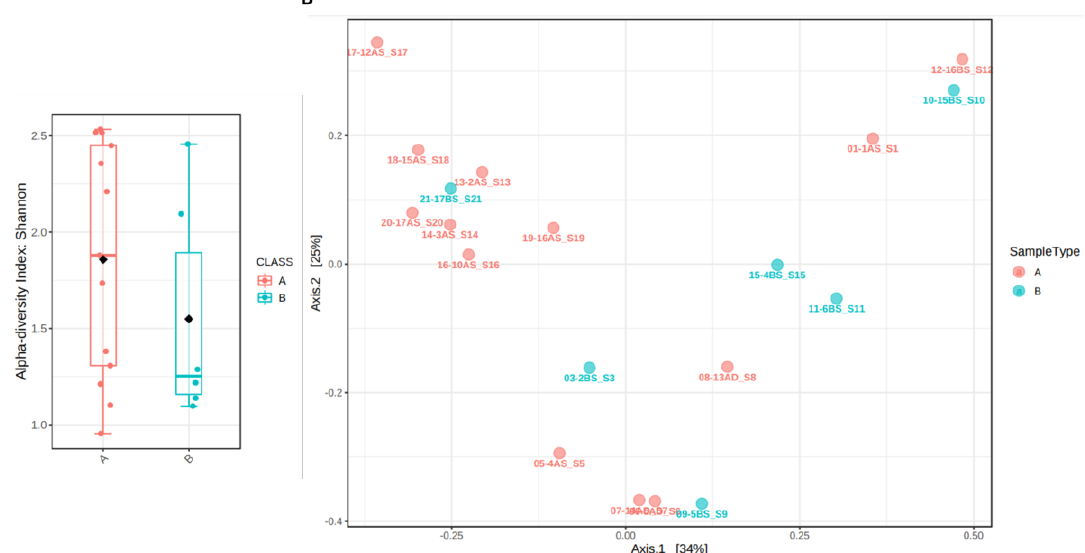
Figure 4. Determinations of alpha ( A ) and beta diversity PCoA ( B ). Alpha-diversity measure using Shannon index at Species level is represented as boxplot; each boxplot represents the diversity distribution of a group (Shannon index values are reported in Figure S2). Beta diversity is represented as a 2-D PCoA plot using Bray–Curtis distance. The statistical significance of the clustering pattern in ordination plots is evaluated using Permutational ANOVA (PERMANOVA). Each axis reflects the percent of the variation between the samples with the X -axis representing the highest dimension of variation and the Y -axis representing the second highest dimension of variation. The explained variances are shown in brackets.